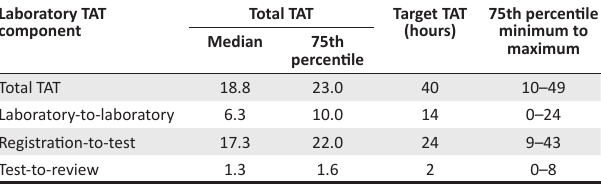
TABLE 1: National annual National Health Laboratory Service CD4 total turn- around time for all samples tested during the 2016/2017 financial year. Laboratory TAT component